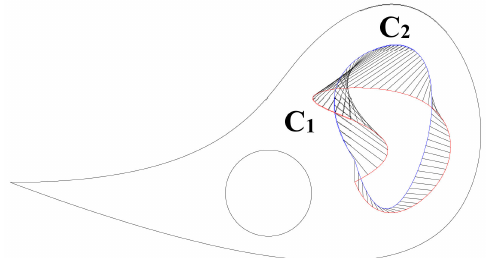
Figure 8. Moving subtraction when a hole varies from C 1 (red) to C 2